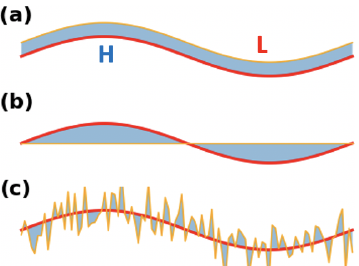
Figure A1. Example faults with ED when distinguishing data that have a spatial and temporal correlation. Suppose we have two dis- tributions represented by red and orange lines in each plot (a–c) , where “H” and “L” are the locations of a high and a low, respec- tively. In panels (a) – (c) , the red and orange lines have the same ED; meanwhile, if using the S-SIM index to compare the lines, one will have the highest S-SIM value in panel (a) , followed by panel (c) ; the S-SIM values in both panels (a, c) are much higher than that in panel (b) .